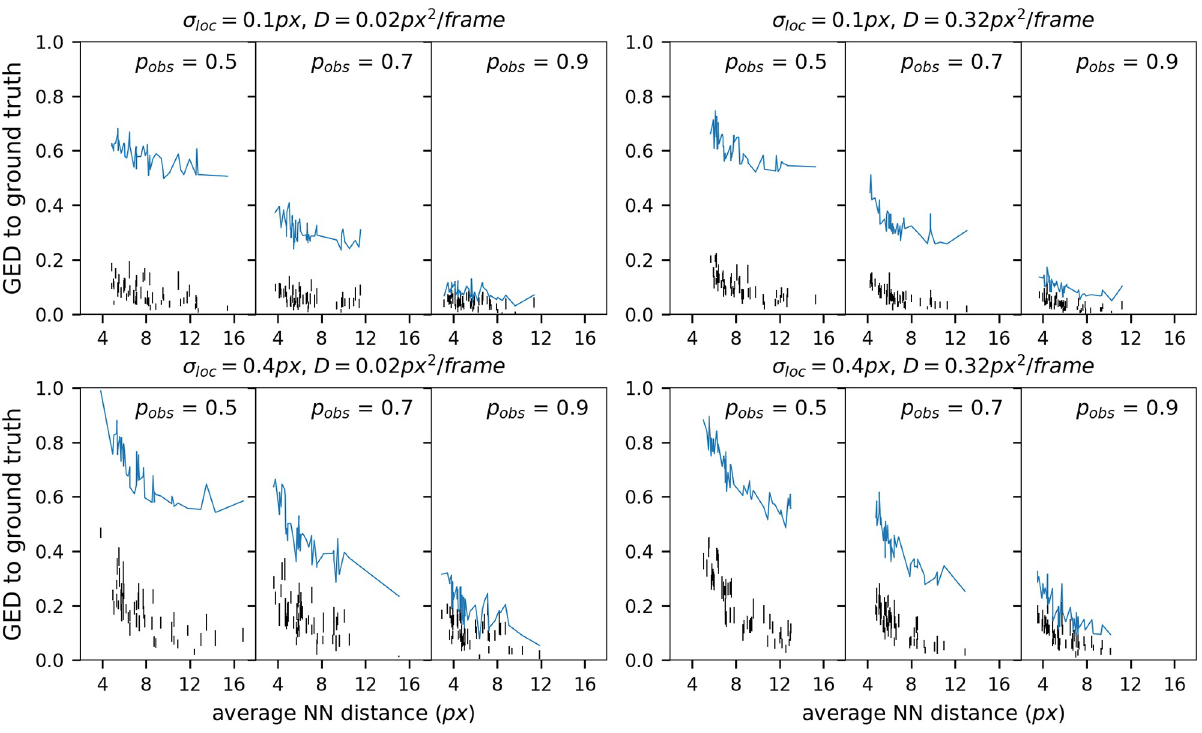
Fig 8. Comparison between Biggles and uTrack. The uTrack results are shown in blue, one point per tracking result, the points connected by a line. The Biggles results are shown as vertical black lines, each line represents a single tracking result connecting the value of best with the value of the worst sample. The GED to the ground truth (number of wrong links + number of missed links) is normalised by the number of observations of the data set.